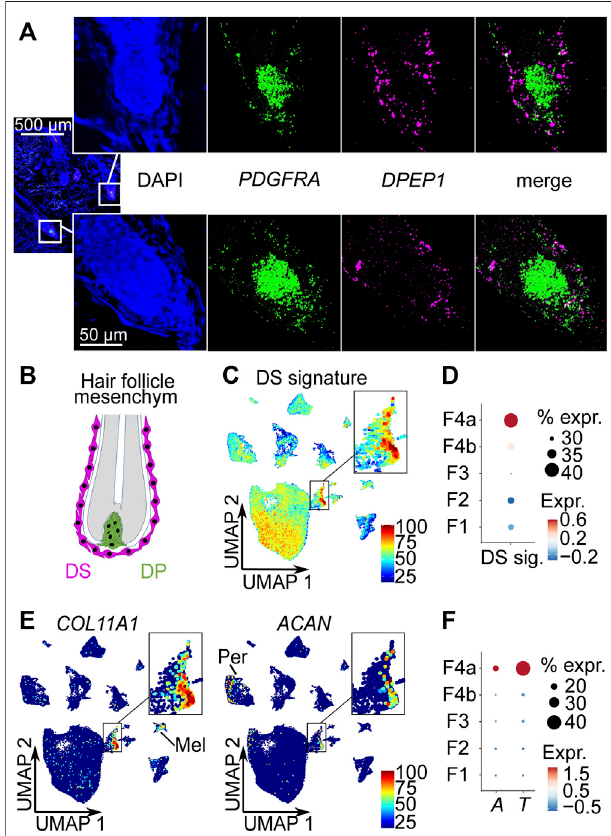
FIGURE1| Thecellularcompositionofdermal fi broblastschangesupon aging. (A) Experimental design. (B) Uniform Manifold Approximation and Projection (UMAP) plots of fi broblasts of young and old participants. (C) Expression of reticular ( WISP2 , SLPI , CTHRC1 , MFAP5 , TSPAN8 ), papillary( APCDD1 , ID1 , WIF1 , COL18A1 , PTGDS ),pro-in fl ammatory( CCL19 , APOE , CXCL2, CXCL3, EFEMP1 ) and mesenchymal ( ASPN, POSTN, GPC3, TNN, SFRP1 ) markers (Solé-Boldo et al., 2020) among fi broblasts in UMAP plots. (D) Box plot of percentages of cells in fi broblast populations young vs. old, **** p < 0.0001 (Fisher ’ s exact test). (E) Marker expression in UMAP plots, subclustering of population 4 into 4a and 4b. (F) Box plot of percentages of cellsin fi broblastpopulations4aand4byoung,vs.old,**** p < 0.0001(Fisher ’ s exact test). F1-F4b Fibroblast populations 1 – 4b, yr years, y young, o old.